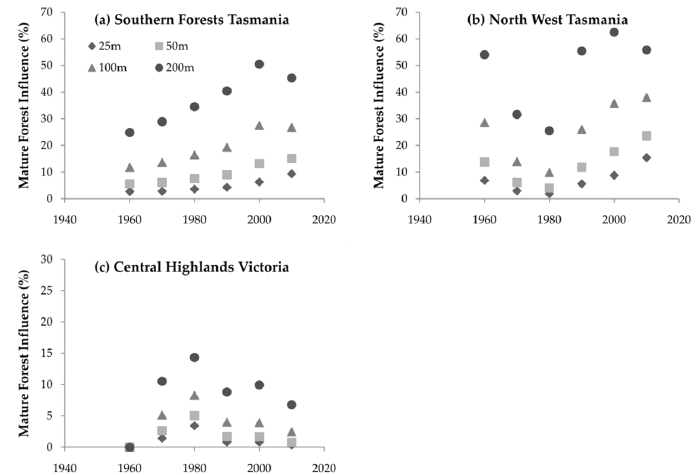
Figure 5. Average proportion of harvested patch area within 25 m, 50 m, 100 m, and 200 m of structurally mature forest (i.e., mature forest influence) over time for ( a ) Southern Forests Tasmania; ( b ) North West Tasmania; and ( c ) Central Highlands Victoria.